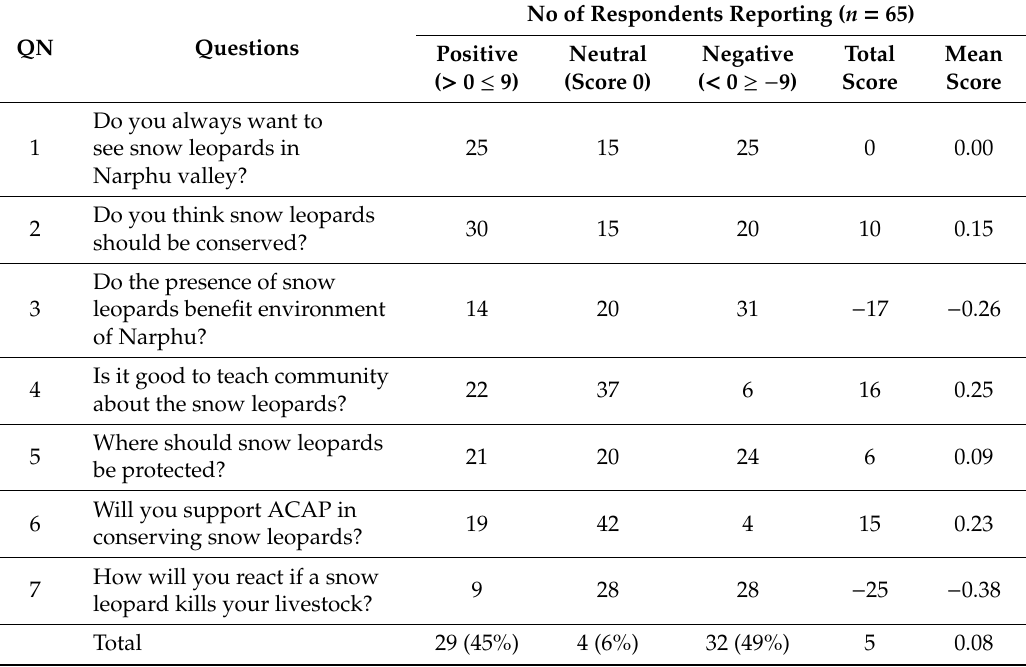
Table 5. Scoring from attitude survey of herders ( n = 65) towards snow leopard conservation 1 . (ACAP = Annapurna Conservation Area